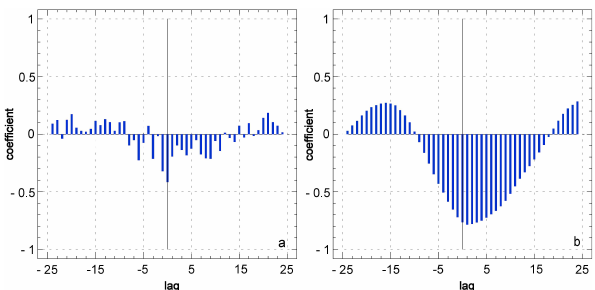
Fig. 4. Cross-correlation analysis between the winter NAOI and the MAPI carried out on (a) the original time series and (b) the 11-yr moving average time series.